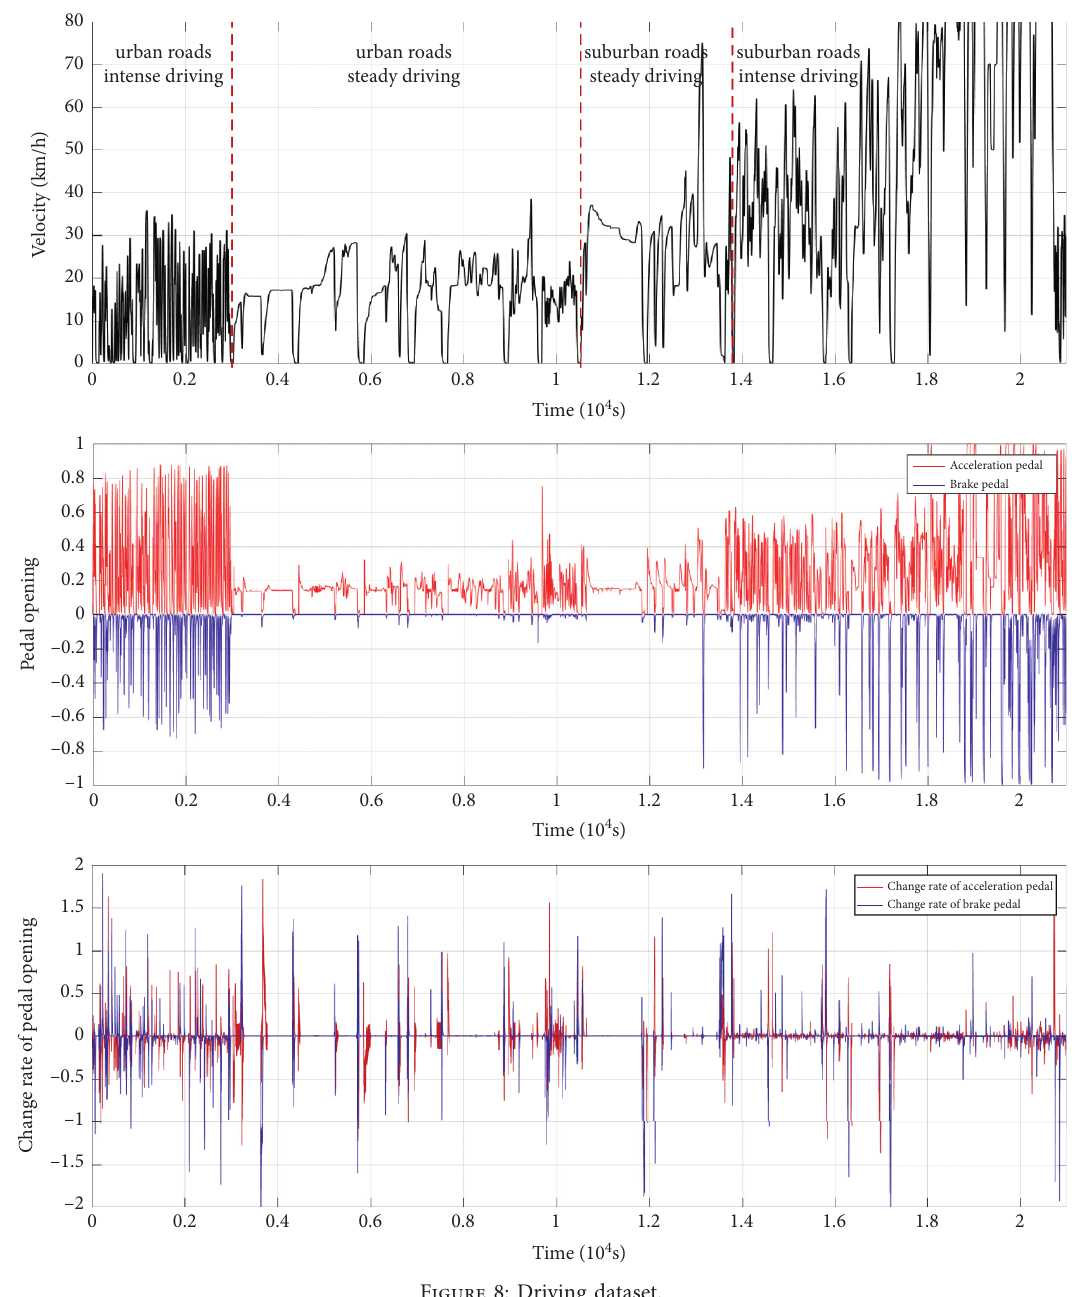
Figure 8: Driving dataset.